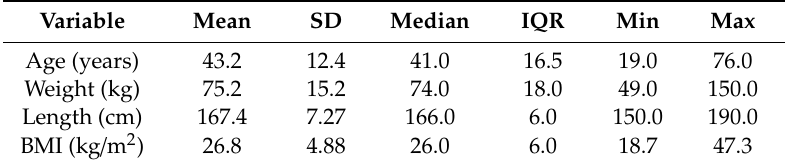
Table 1. Anthropometric parameters of the group of 107 volunteer fat tissue donators.